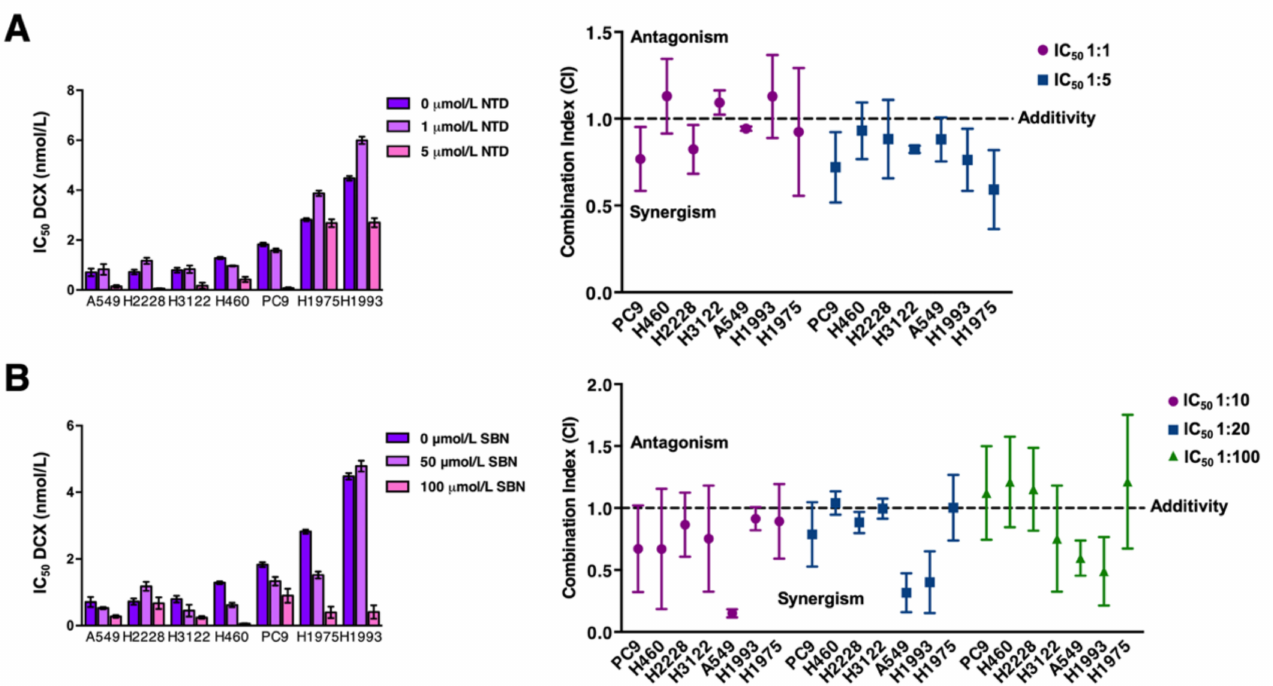
Figure 2. Analysis of the cytotoxic interaction between docetaxel, nintedanib, and silibinin in NSCLC cells. Left panels. Bar graph showing the MTT-based IC 50 values of docetaxel (DCX) for each cell line calculated in the absence or presence of graded concentrations of NTD ( A ) and SBN ( B ). Right panels . Computed combination index (CI) values for the combination of DCX plus NTD ( A ) and DCX plus SBN ( B ) at 50% effect levels using different fixed ratio combinations of the drugs. CI values less than, equal to or greater than 1 indicates synergy, additivity or antagonism, respectively. The horizontal line at CI = 1 is the line of additivity. The results in A, B, C and D panels are presented as the means ( columns ) ± S.D. ( bars ) ( n = 3, in